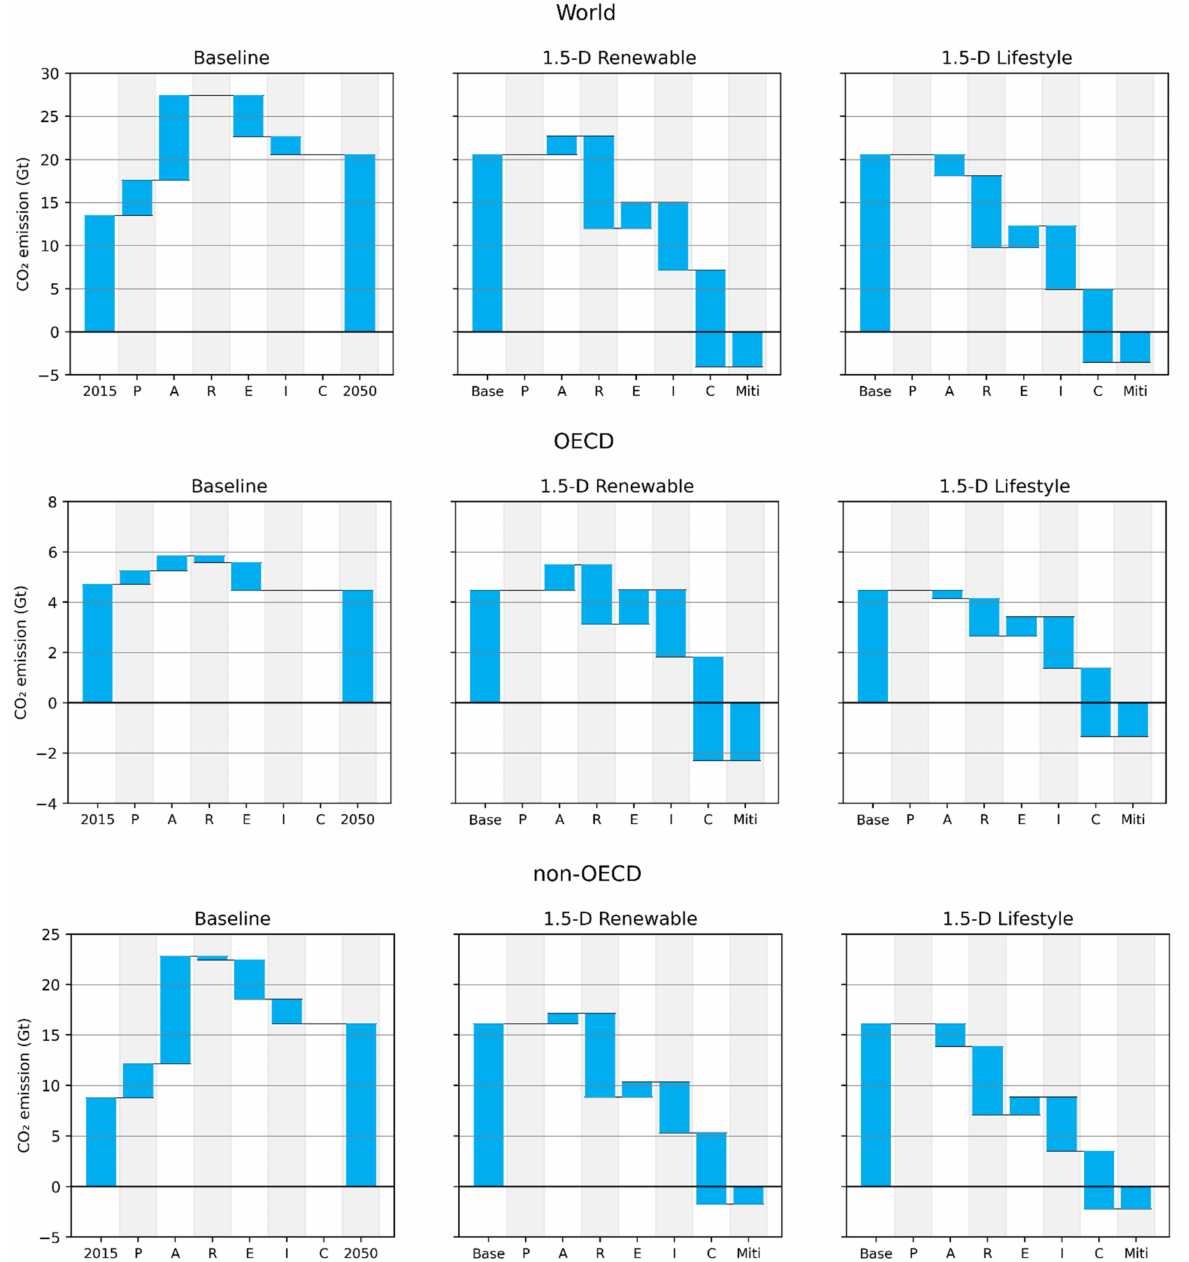
Figure 2. Changes in power generation emissions between 2015 and 2050 (Baseline) and between Baseline and the mitigation scenarios (in 2050) due to different drivers. P: population growth, A: activity changes, R: renewable and nuclear share, E: efficiency, I: carbon intensity, C: